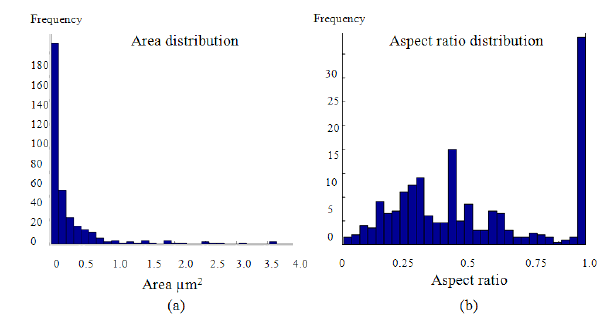
Figure 6. Pore spaces statistics for sample S 1 : a) Pore spaces size distribution, b) Aspect ratio 2 Fig. 6. Pore spaces statistics for sample S 1 : (a) Pore spaces size distribution. 3 distribution, (b) Aspect ratio